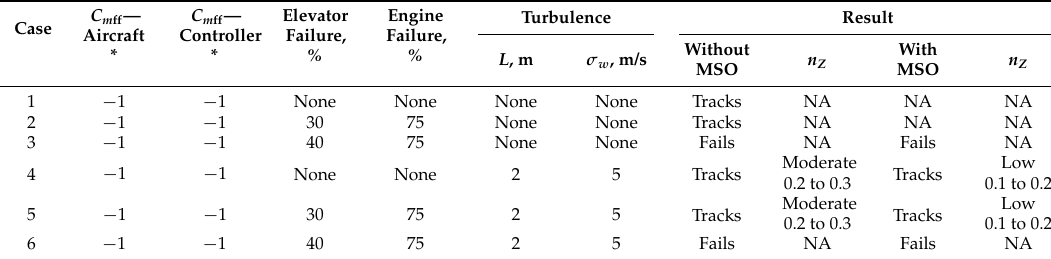
Table 3. Simulation results—No modeling